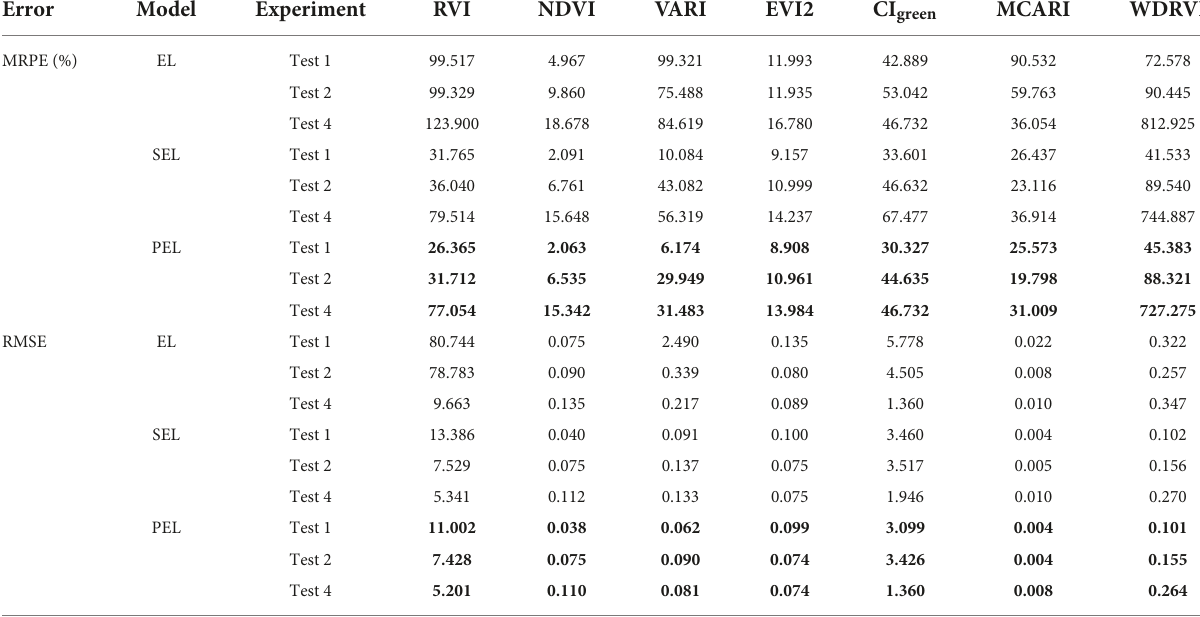
TABLE 4 Statistical results of VI accuracy of different radiometric calibration methods in Test 1, Test 2, and Test 4. Error